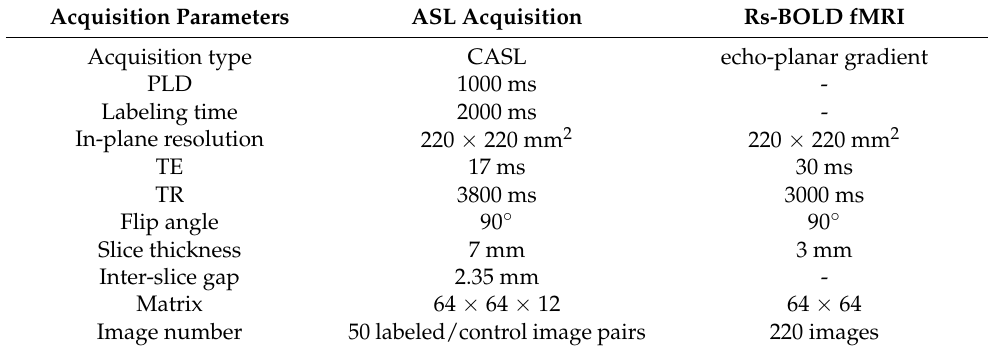
Table 1. Illustration of the different ASL and rs-BOLD fMRI acquisition parameters described in [46]. Acquisition